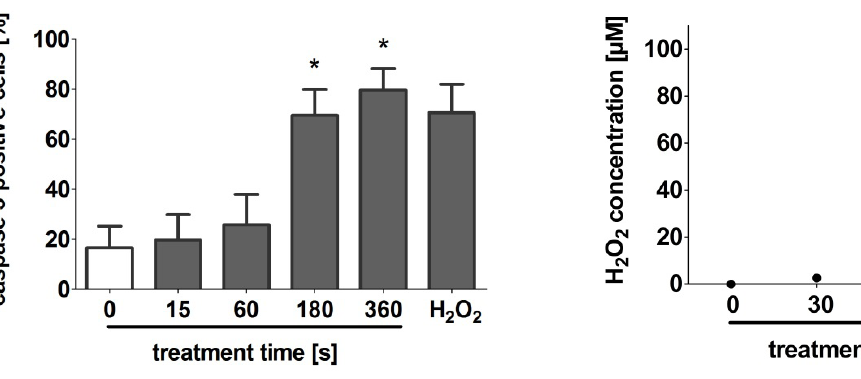
O concentration of plasma treated cell culture medium Figure 5 : H 2 2 determined by H O test strips after treatment. Data are displayed 2 2 as mean with standard deviation of three independent